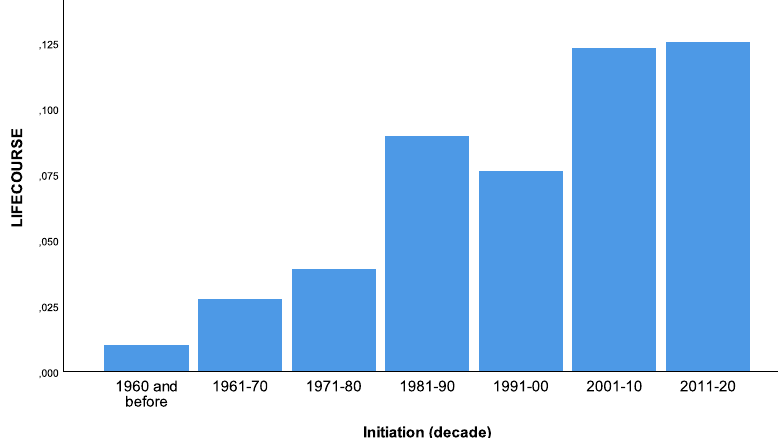
Fig. 4 Effects of decades on the initiation reason life-course event. Life-course events as reason for initial involvement in relation to decade of